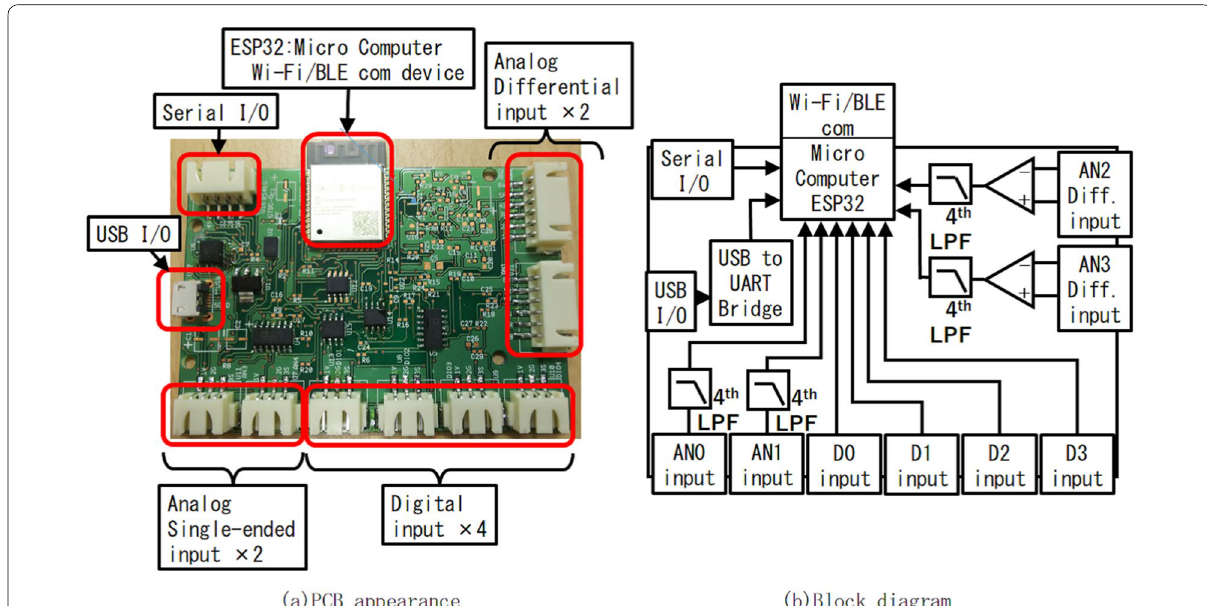
Fig. 6 A PCB appearance and block diagram a A PCB design and development to modularize the measurement sensor system -in the walker, it is used universally for both the Modules A and B, b PCB circuit block diagram in which an ESP32 microcomputer was used -it has Wi-Fi and Bluetooth communication functions, an AD converter, GPIO, and other